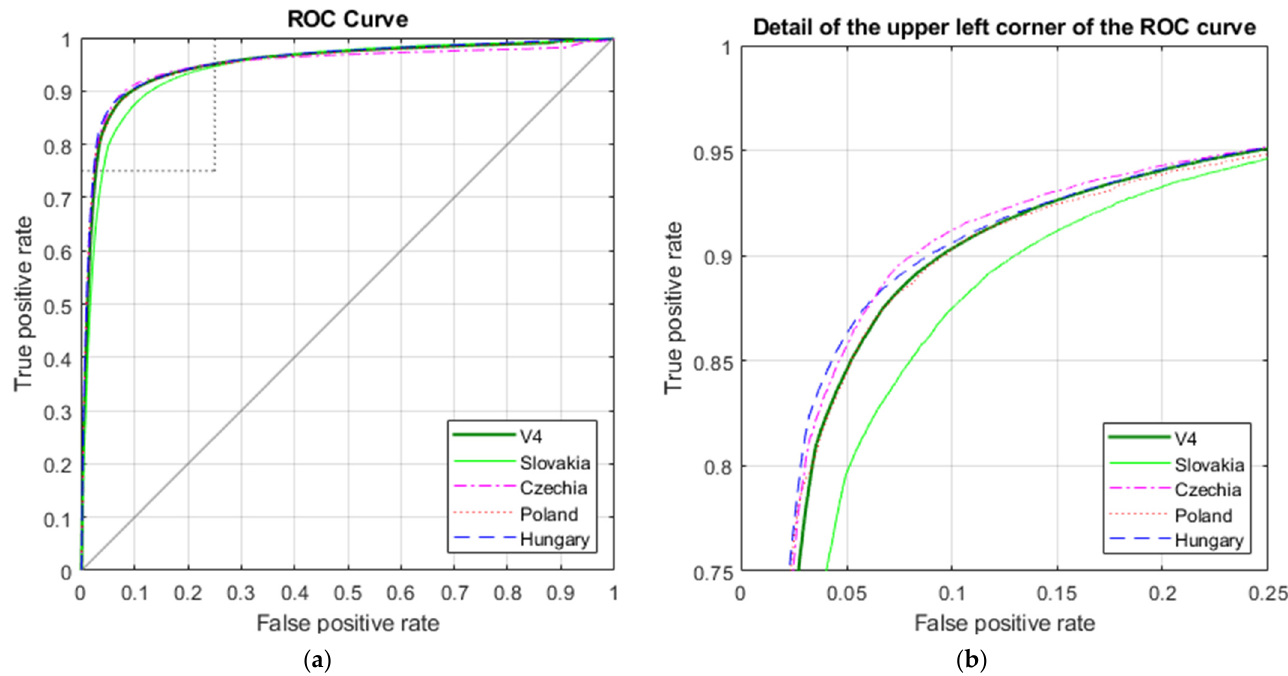
Figure 5. ROC curves of the Visegrad Group and its countries. ( a ) The shape of ROC curves on the whole interval, ( b ) the detail of the ROC curves.